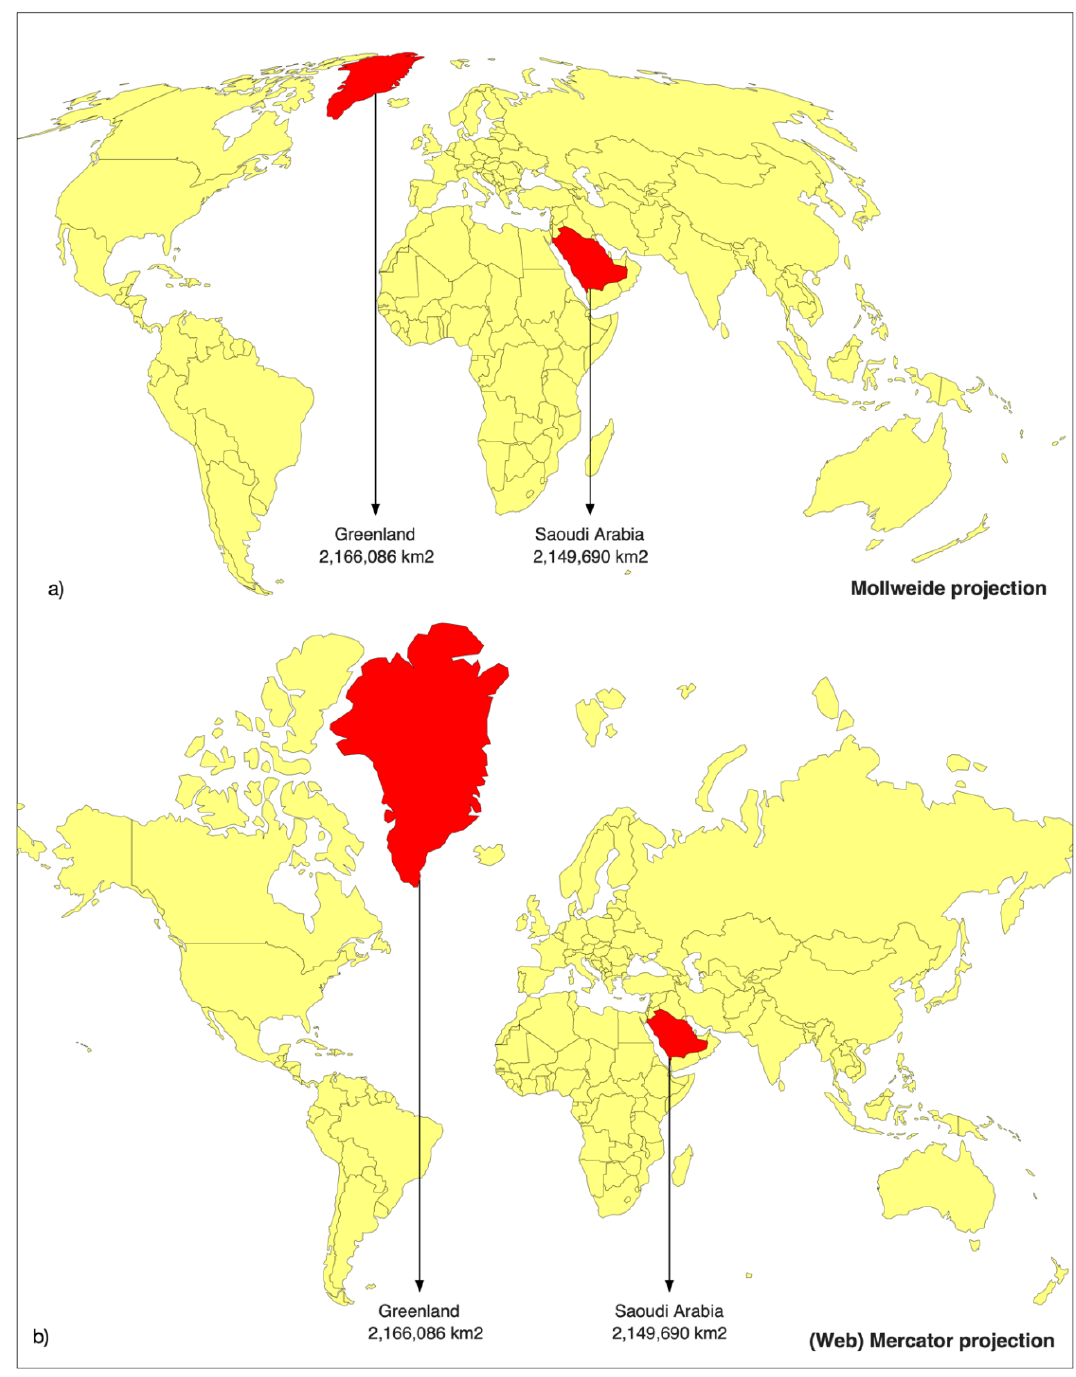
Figure 5. Basemap considerations including projections. Here is an example comparing the size of Greenland and Saudi Arabia displaying differences resulting from projection choices: ( a ) Mollweide; ( b ) Mercator.